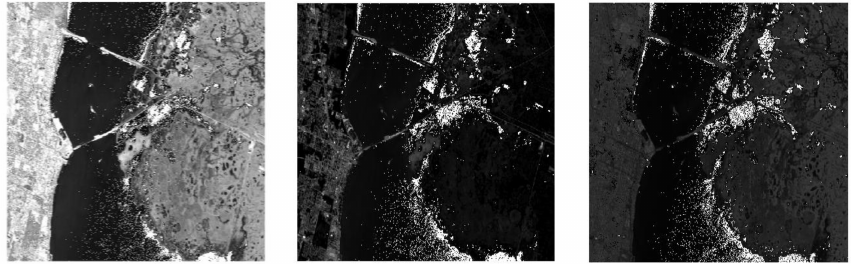
Figure 8. Plot of three arbitrary selected ICs components from the DCT-ICA feature space in the Kennedy Space Center